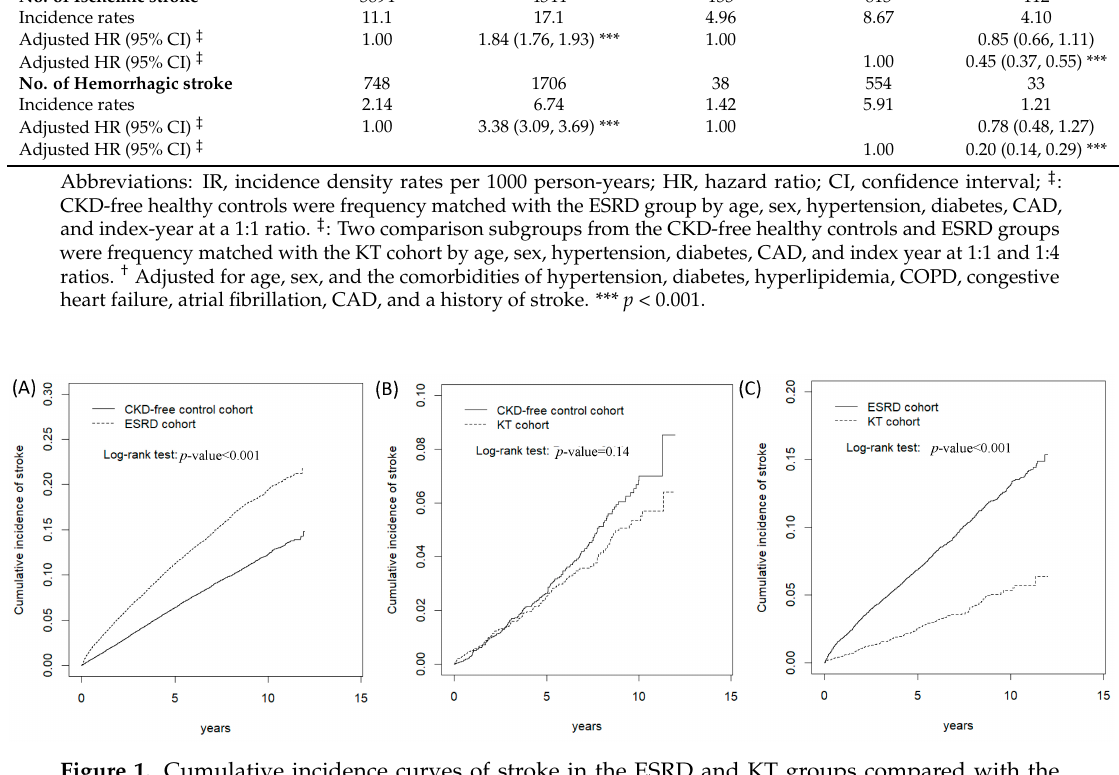
Figure 1. Cumulative incidence curves of stroke in the ESRD and KT groups compared with the CKD-free control group. Cumulative incidence curves of stroke in the ESRD compared with the CKD-free control group ( A ), KT groups compared with the CKD-free control group ( B ), KT groups compared with the ESRD groups ( C ).